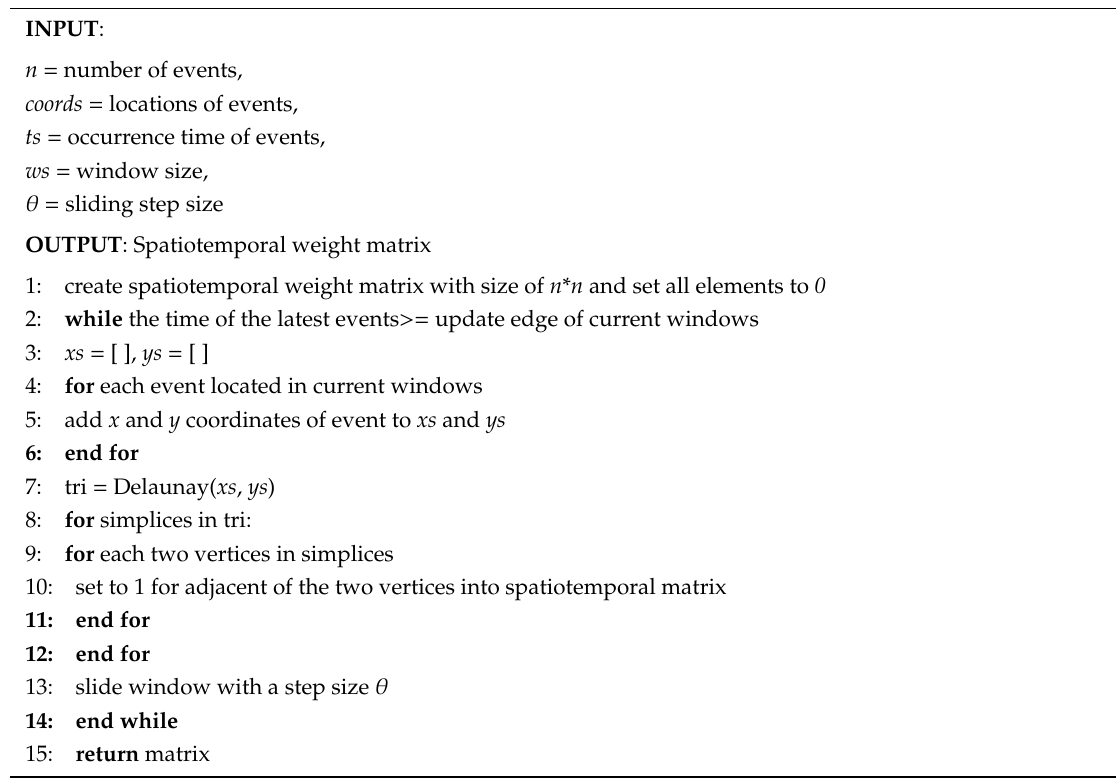
Algorithm 1. Building spatiotemporal weight matrix by sliding window